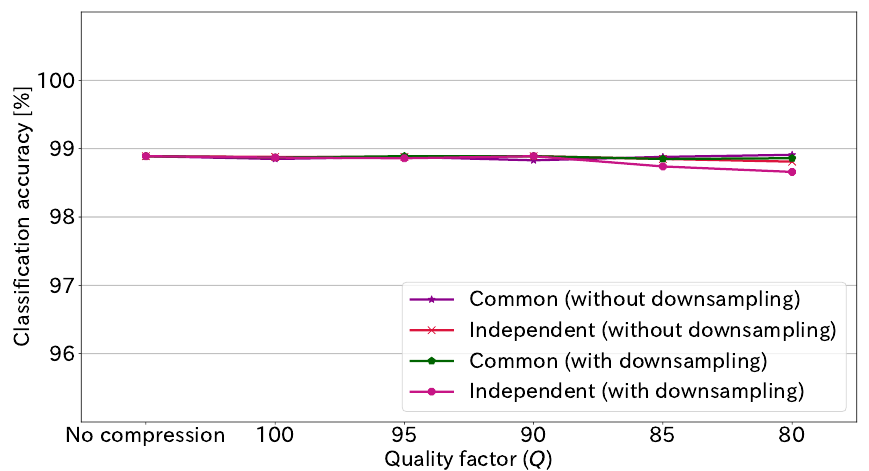
Figure 12. Classification accuracy at each quality factor with and without downsampling ( S sb =